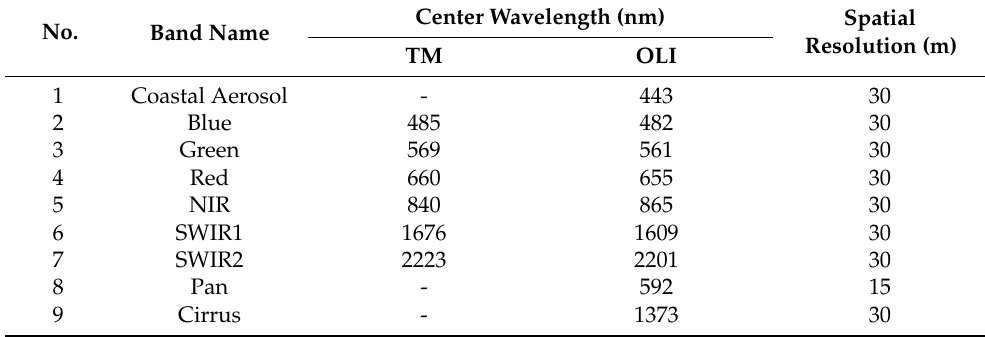
Table 1. Band specifications of the Landsat Operational Land Imager and Thematic Mapper.